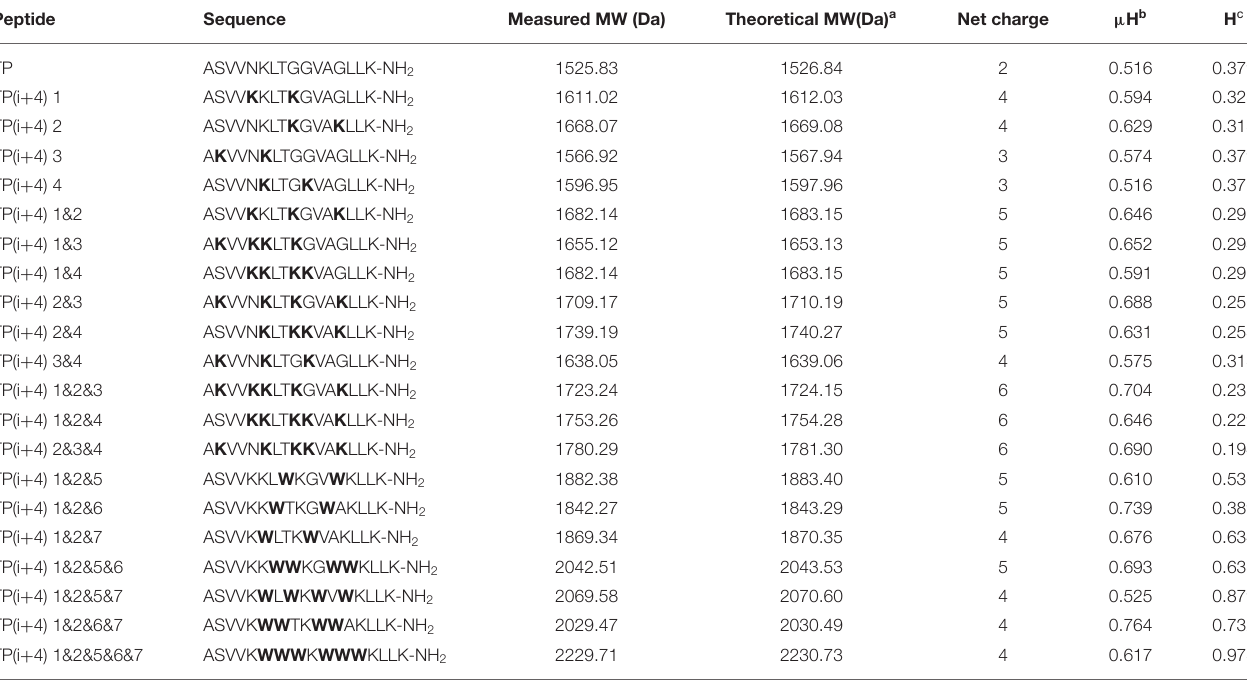
TABLE 1 | Sequence and key physicochemical parameters of amphiphiles.